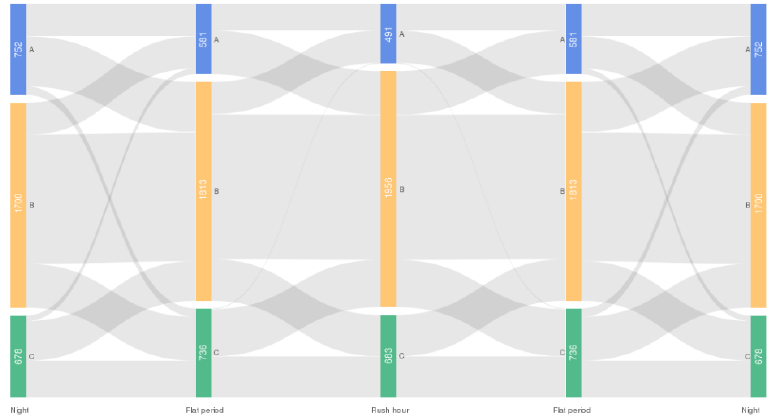
Figure 7. Driving style shifts of ride-hailing drivers.